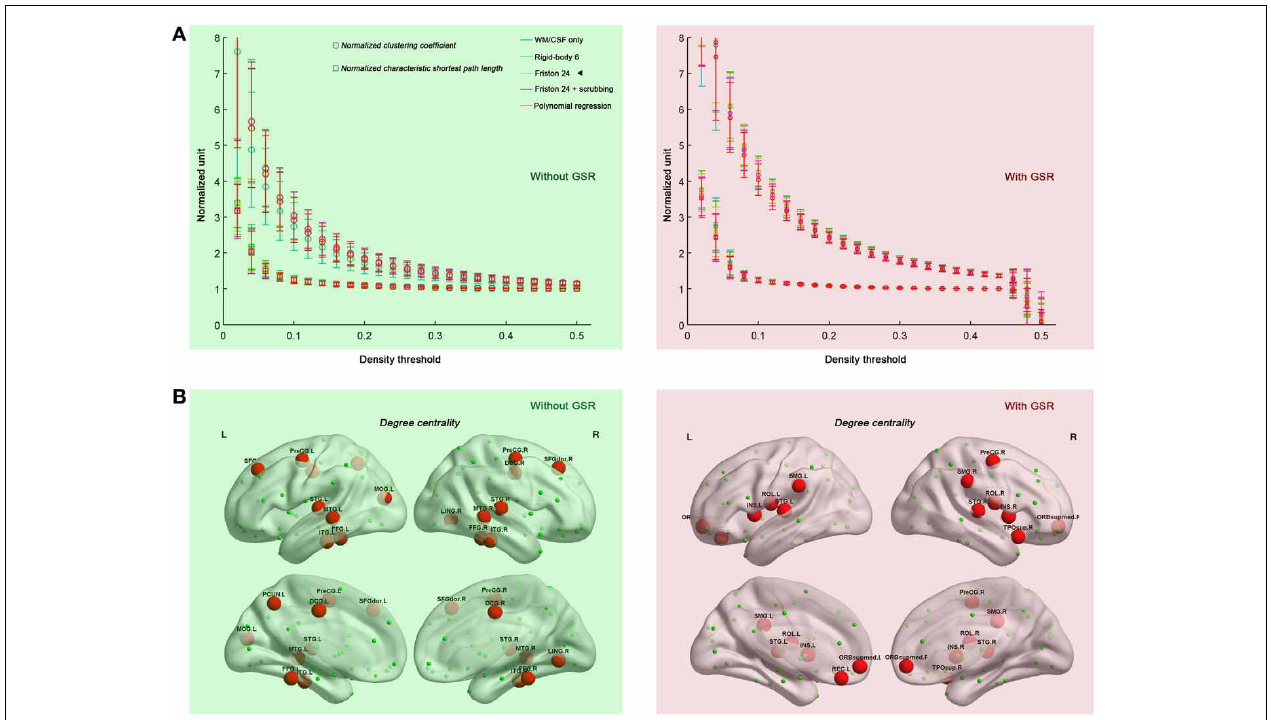
FIGURE 2 | Small-world properties (A) and hub distributions (B) under different head motion correction strategies. Five preprocessing strategies were evaluated in combination without GSR (green shaded) and with GSR (pink shaded). “ (cid:2) ” in panel (A) indicates that the hub distribution demonstrated in panel (B) is derived from Friston 24 model. The hub